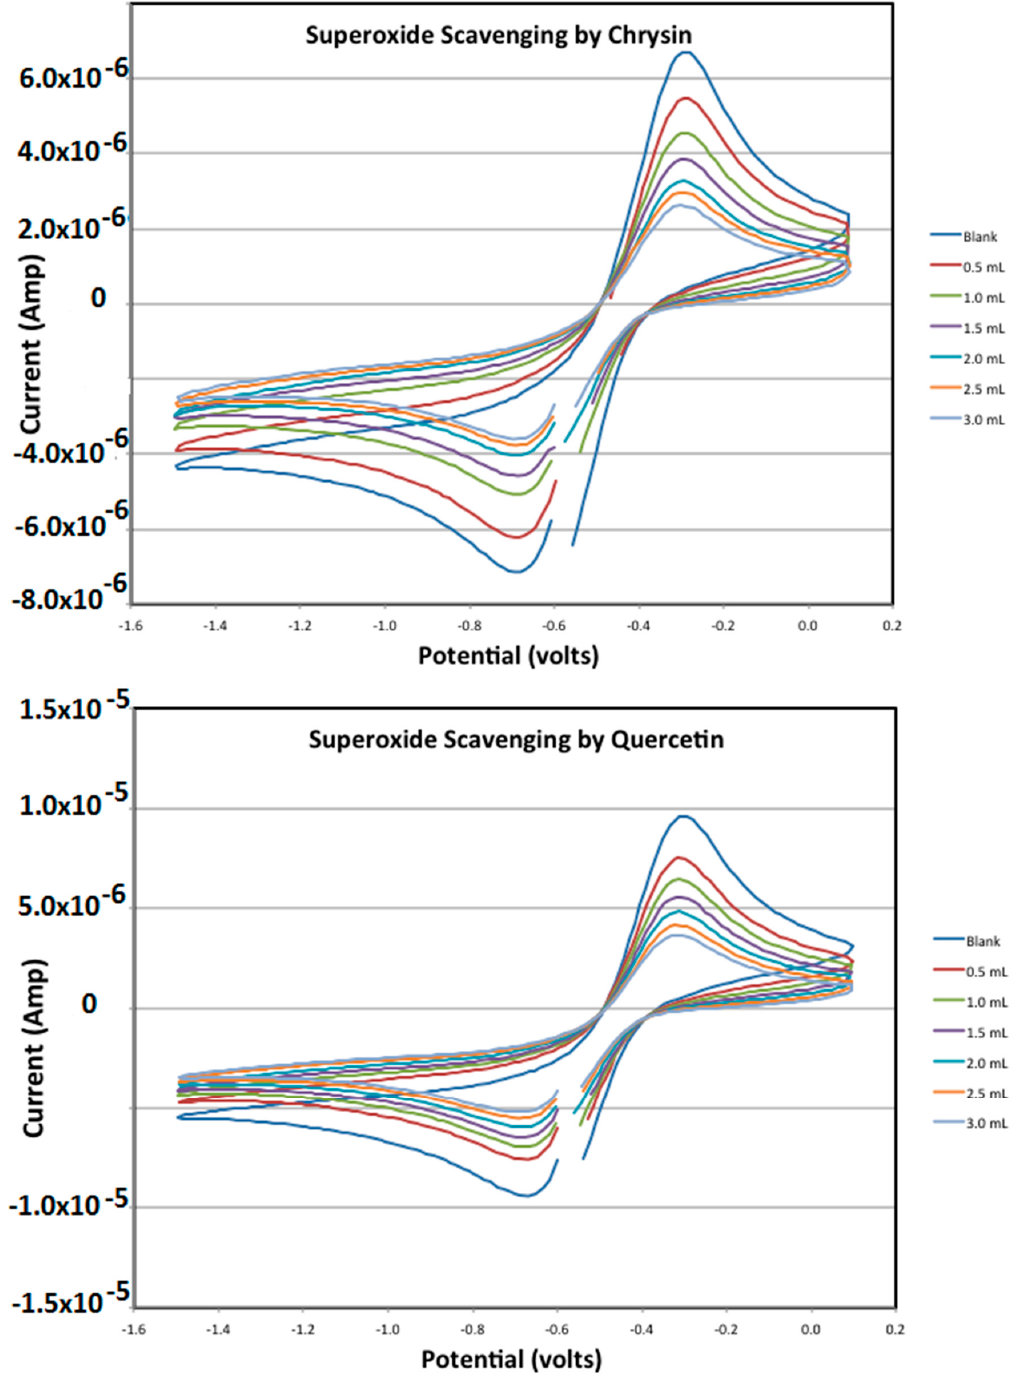
Figure 7. CV (cyclic voltammetry) of chrysin and quercetin showing the decrease in oxidation peaks as their aliquots were added.